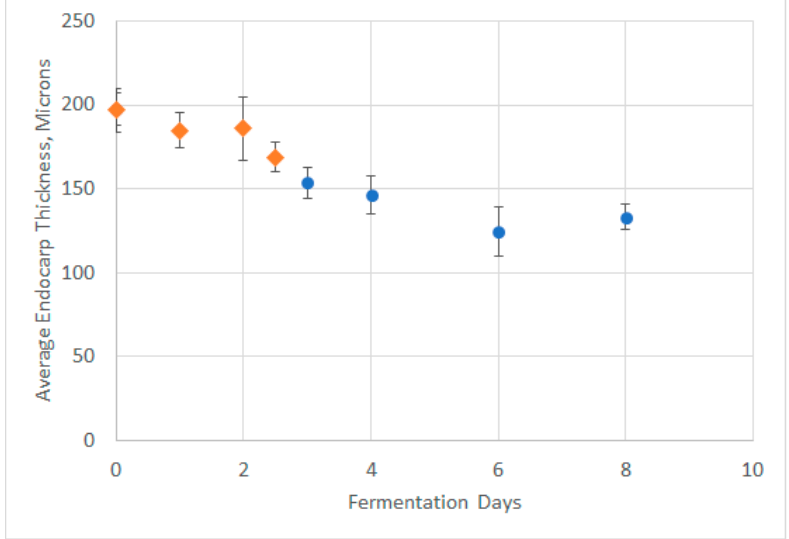
Figure 7. Seed Endocarp thickness over time. Note that two time points from repeat fermentation with the same grapes are overlaid: 0–2.5 days, orange diamonds; 0–8 days, blue circles (note first seed tannins over the course of fermentations. tannins over the course of